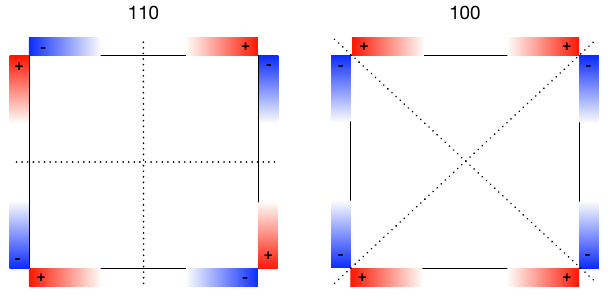
Figure 6: Two mass sign configurations respecting bulk and surface mirror symme- tries as well as C symmetry for the positive momentum surface cone of the ( 110 ) 4 wire (left) and one of the two surface cones of the ( 100 ) wire (right). The second cone of the ( 100 ) wire replaces all blue with red, red with